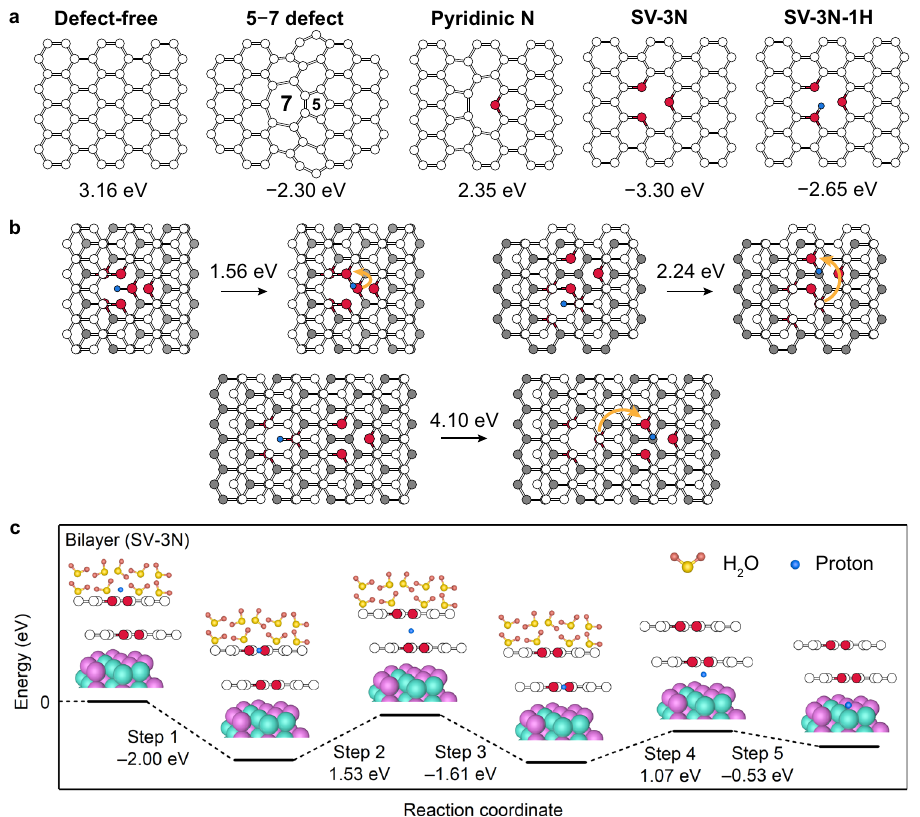
Fig. 5 DFT calculations. a Atomic models of various types of graphene lattice. The numbers under the graphene lattices are the calculated energy barriers for proton penetration through the lattices. A positive or negative value indicates that the shape of the potential energy surface involves a peak or a trough (details in Supplementary Fig. 36). b Energy barriers for proton hopping between bilayer SV-3N graphene lattices (the fi rst layer is white and the second layer is grey). Orange arrows indicate the hopping direction. c Energy diagram for proton penetration through a bilayer SV-3N graphene lattice. The proton was adsorbed on a NiMo nanoparticle after penetrating through the graphene-covering bilayer. Colour code: carbon (white), nitrogen (red), proton (blue), nickel (cyan), molybdenum (purple), oxygen (light yellow), and hydrogen (dark